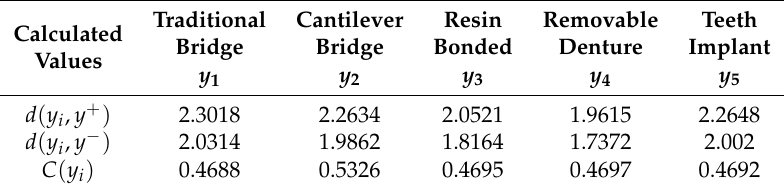
Table 14. Distance measures and relative closeness